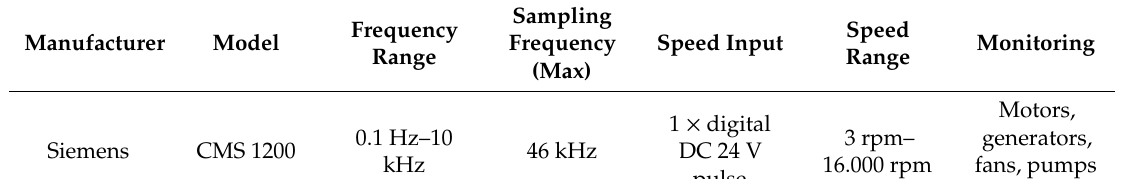
Table 3. Technical parameters of the monitoring device.